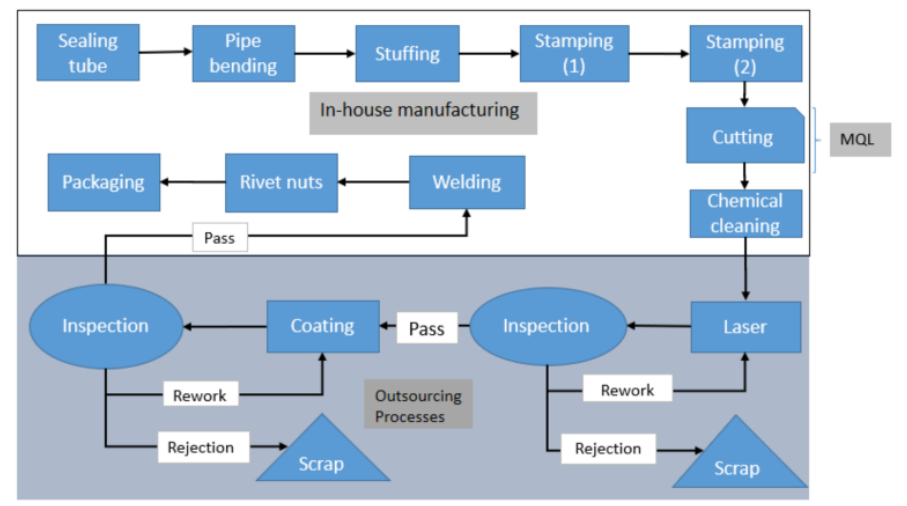
Figure 3. Production flow of automobile